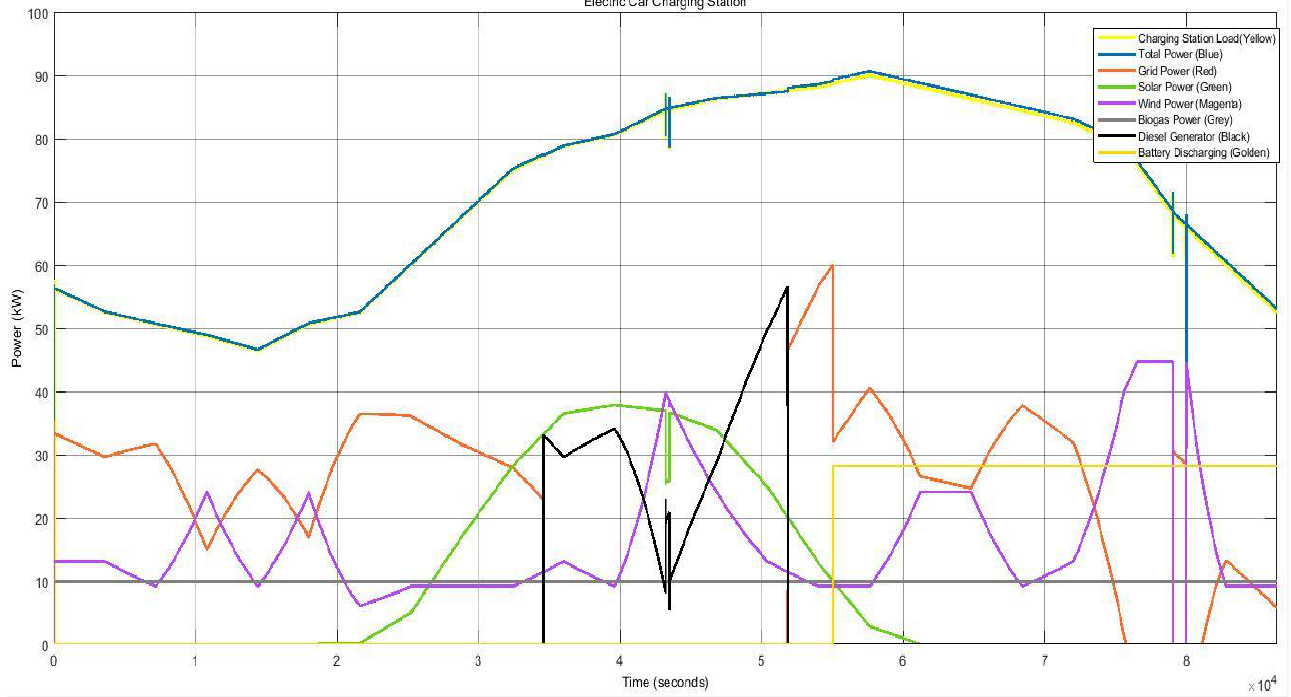
Fig. 13. Power graph of diesel